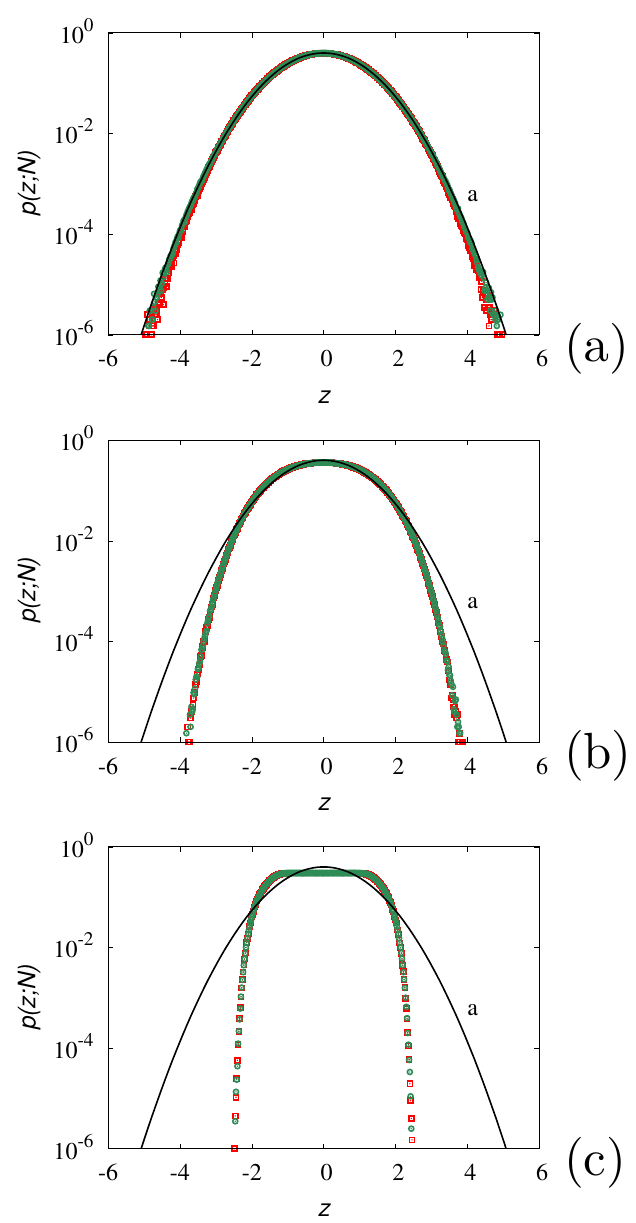
Figure 1. Probability density function p ( z ; N ) for Z N associated with the independent random variables defined by Equation (12). Solid line ( a ) represents the normal pdf g ( z ) = e − z 2 /2 / symbols correspond to the results of Monte Carlo simulations: ( (cid:3) ) N = 100, ( ◦ ) N = 1000. Panel ( a ) refers to α = 1/2, panel ( b ) to α = 1, panel ( c ) to α =